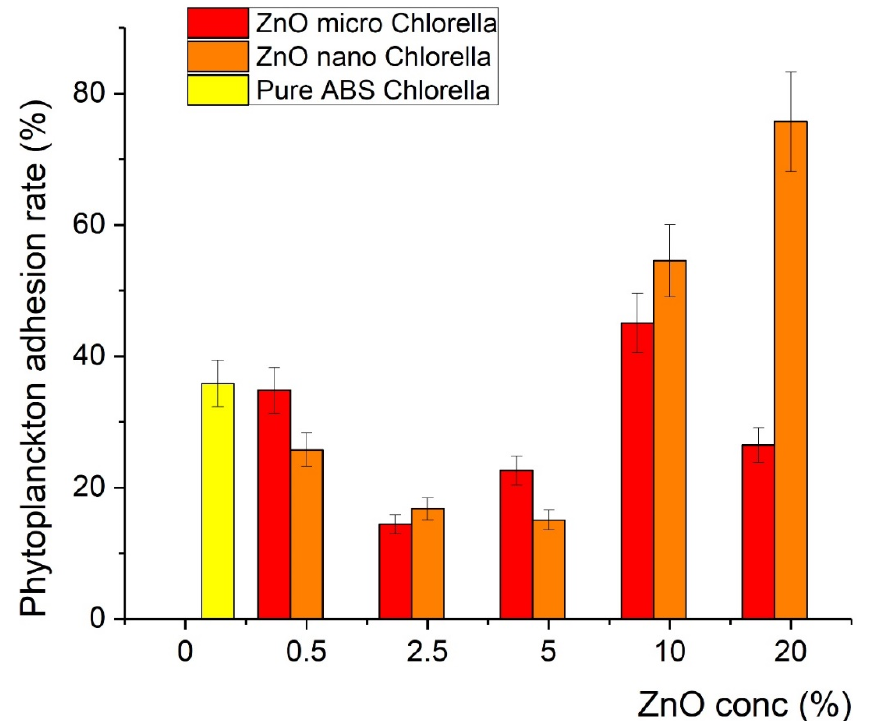
Figure 9. Percentage of coverage of composite material with Chlorella.